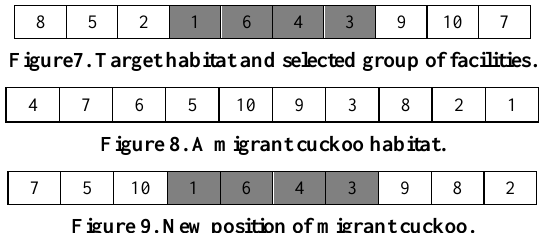
Figure7. Target habitat and selected group of facilities.